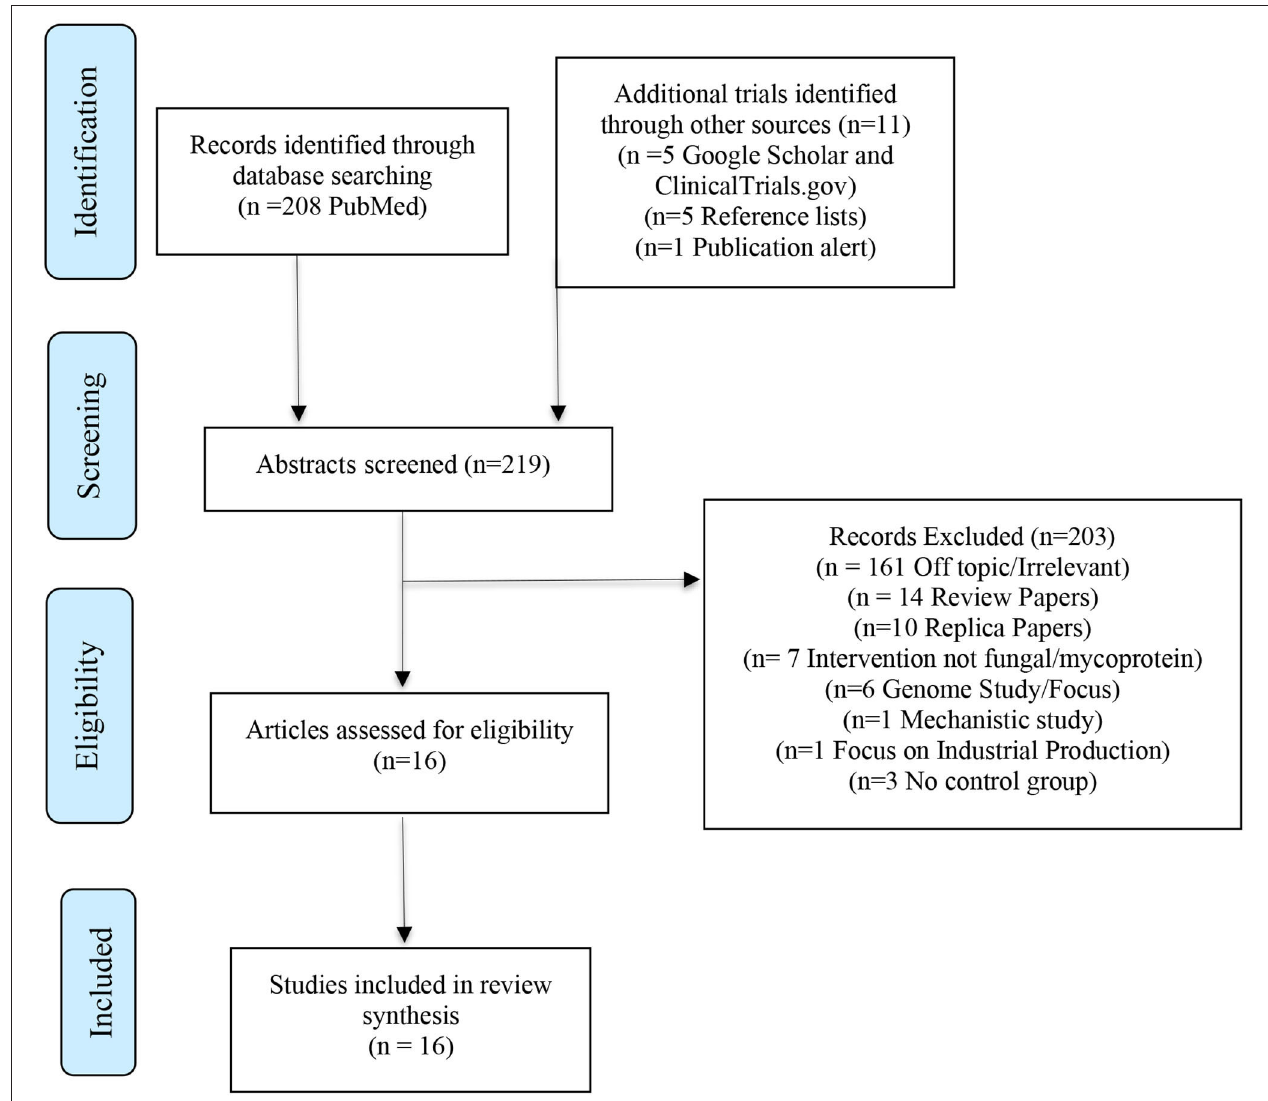
FIGURE 2 | PRISMA approach to identifying trials (Moher et al.,